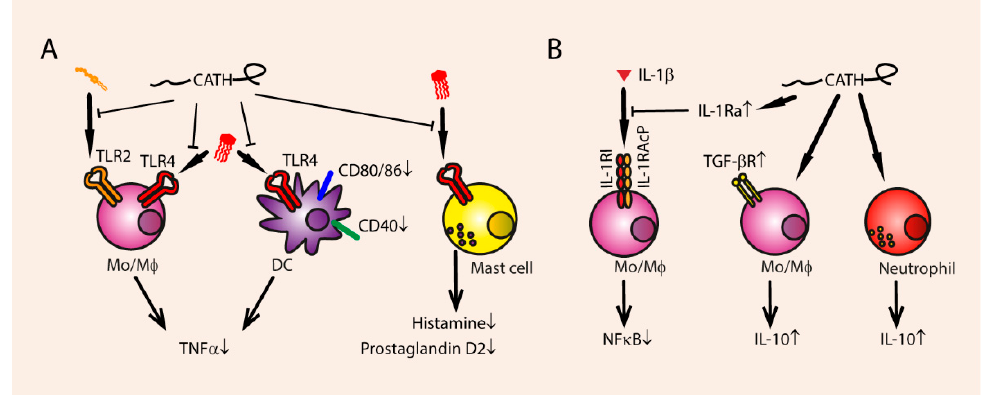
Figure 3. Inhibition of endotoxin-mediated TLR activation by cathelicidins. ( A ) Cathelicidins can bind to LPS, preventing TLR4 activation and thereby reducing TNF α production in monocytes, macrophages and dendritic cells (DCs), also reducing upregulation of CD80/86 and CD40 in DCs. This TLR4 blocking activity can also result in decreased release of histamine and prostaglandin D2 by mast cells. Additionally, cathelicidins can bind the TLR2 ligand LTA, thereby preventing TNF α secretion by monocytes. ( B ) Cathelicidins can directly upregulate IL-10 production in monocytes and neutrophils, and induce upregulation of TGF- β R. Additionally, the upregulation of the IL1 β antagonist IL-1Ra means that IL-1 β induced NF- κ B activation can be